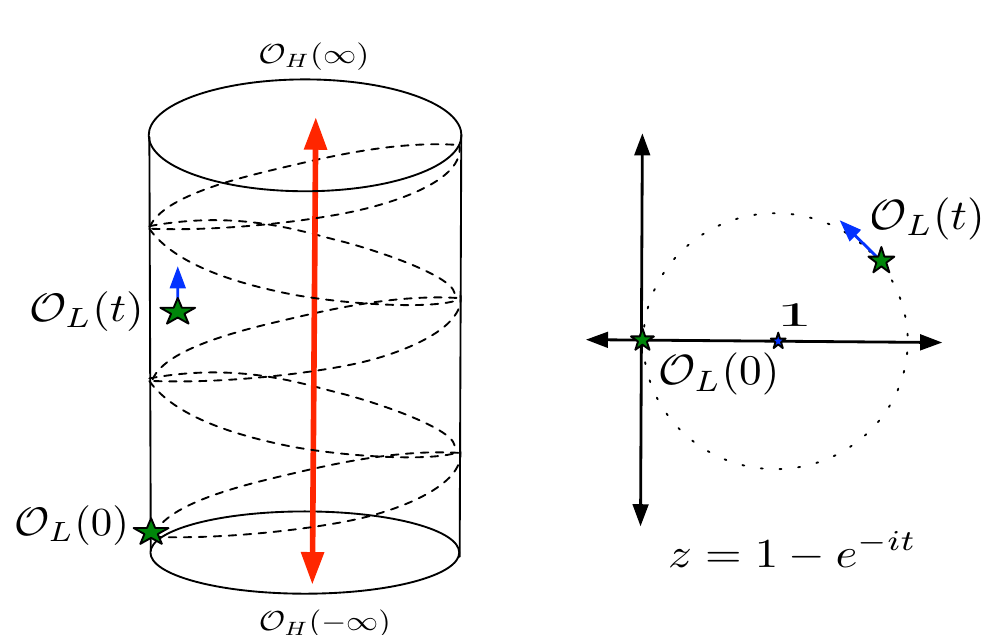
Figure 5 . This (cid:12)gure depicts a generic con(cid:12)guration of the Lorentzian heavy-light correlator, with dashed lines drawn in to indicate past and future lightcones emanating from the operator (0). Due to the cylindrical geometry, as t increases the operator O L future lightcone of (0) at regular intervals. From the point of view of the conventional z -plane, O L depicted on the right, the multi-sheeted CFT correlator transitions to a di(cid:11)erent sheet for each 2 (cid:25) increment of t .